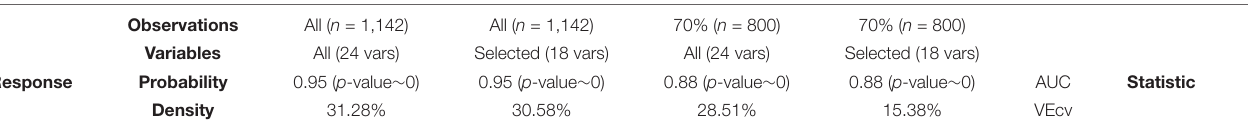
TABLE 2 | Model evaluation